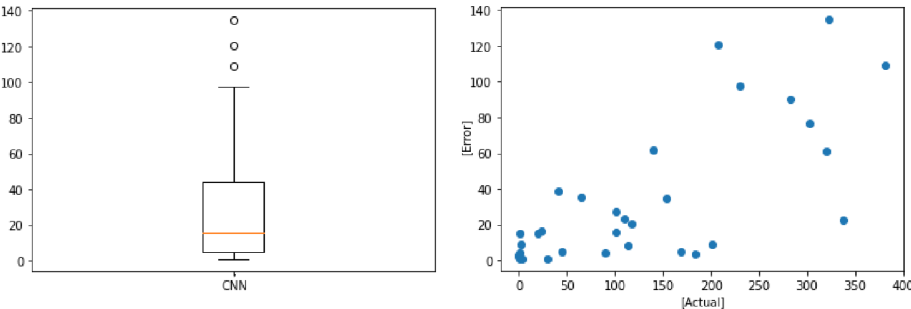
Figure 6. A boxplot and a scatterplot showing the results of our CNN-based regressor on the test set without transfer learning applied.